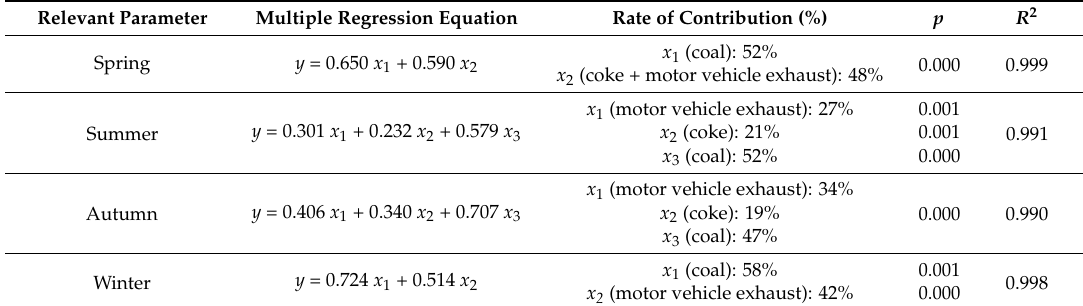
Table 3. Multivariate linear regression model identifying the main factors of the different